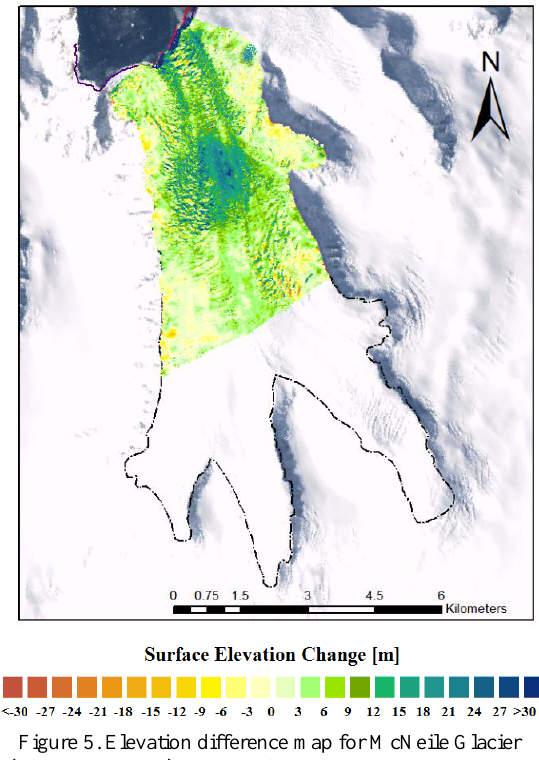
Figure 5. Elevation difference map for McNeile Glacier (AQ7TPE000044). Change from 1957 to 2014. The black dashed line defines the extents of the glacier mapped in stereo. UTM Zone 21S.